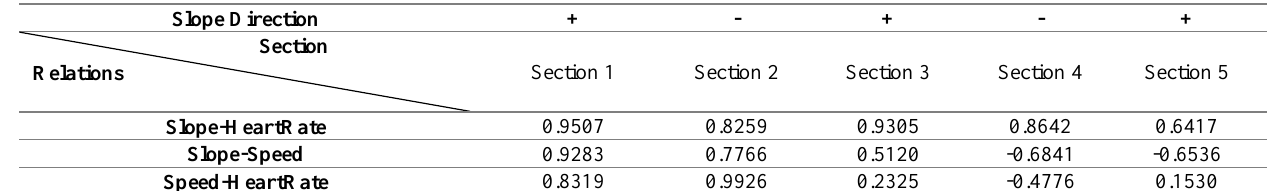
Table 2. Correlation between